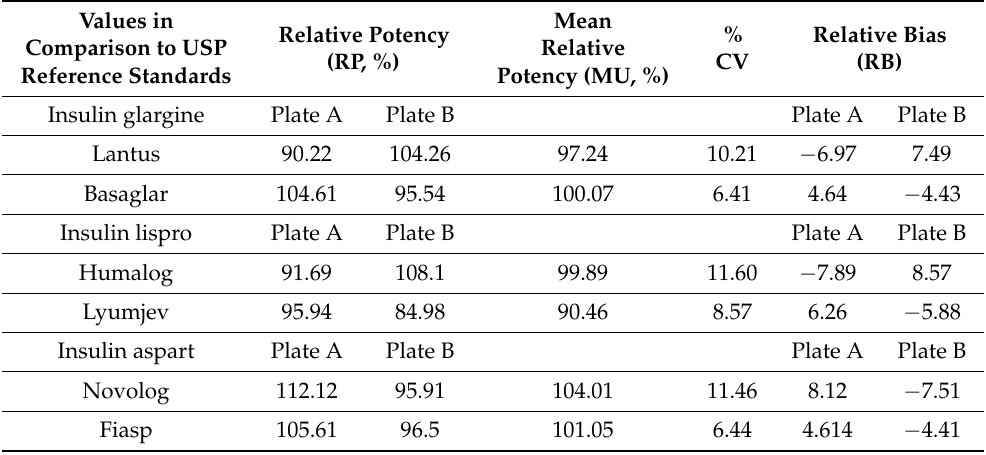
Table 1. Examples of in-cell western insulin bioassay results for insulin glargine, insulin lispro, and insulin